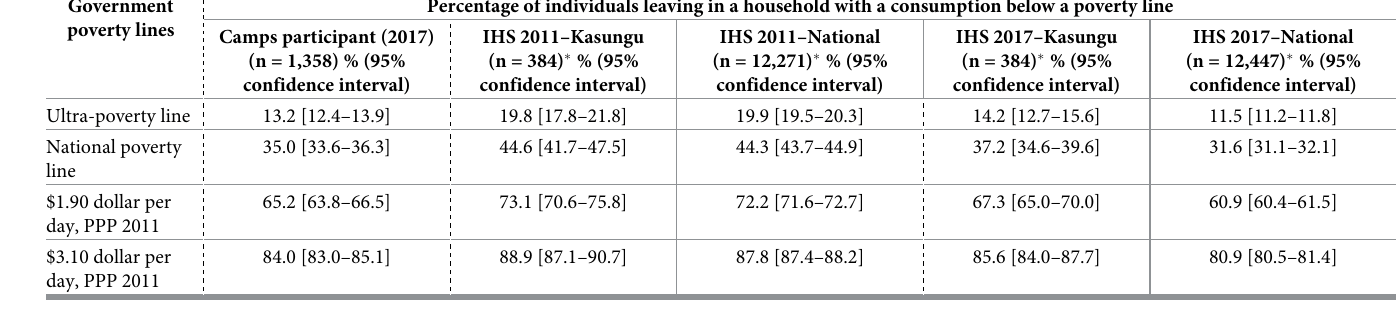
Table 3. Poverty rates using government. Defined thresholds (2011 poverty lines). Government Percentage of individuals leaving in a household with a consumption below a poverty poverty lines